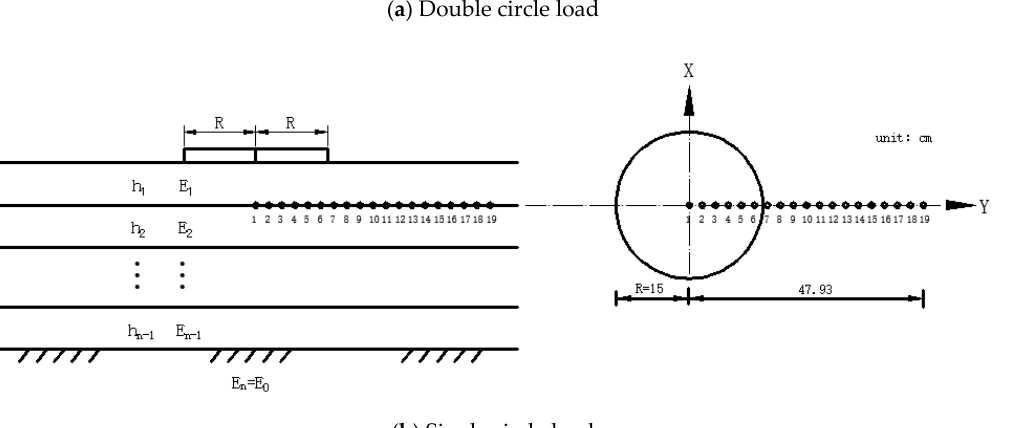
Table 1. Pavement